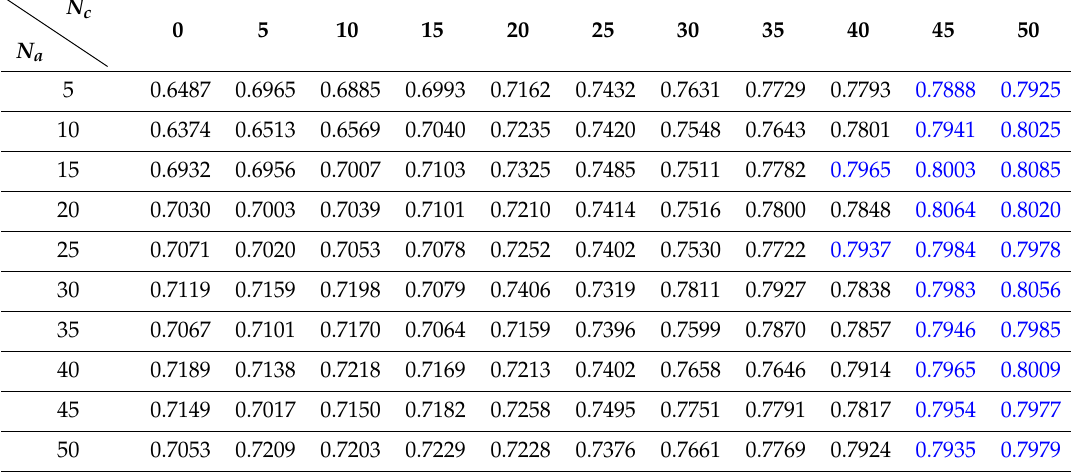
Table 4. Average F-Measure scores obtained on low frame rate category using di ff erent N a and N c . N c N a